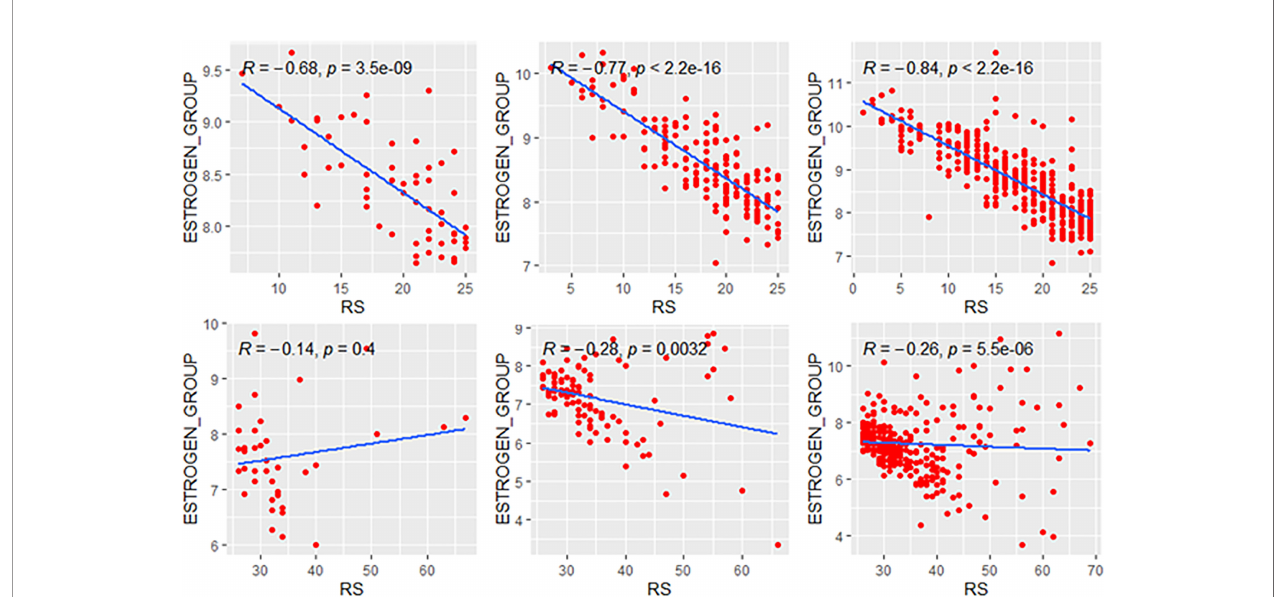
FIGURE 3 | Relationships of the RS with its estrogen module. The upside and downside ranks showed the relationship in patients with RS ≤ 25 and RS >25, respectively. Groups A, B, and C were presented from left to right. RS, recurrence score.